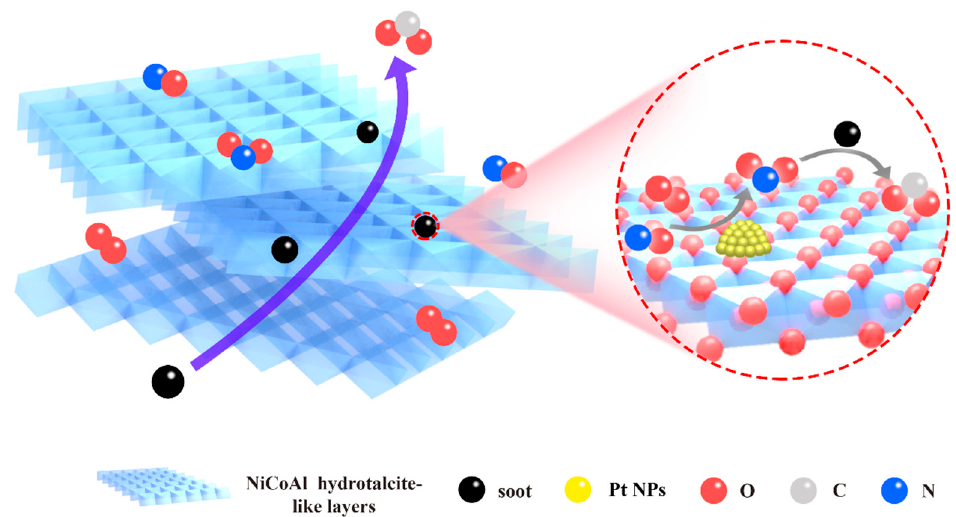
Figure 12. Mechanism diagram of the Pt n /Ni 1.5 Co 0.5 AlO catalysts for soot combustion under loose- contact conditions.